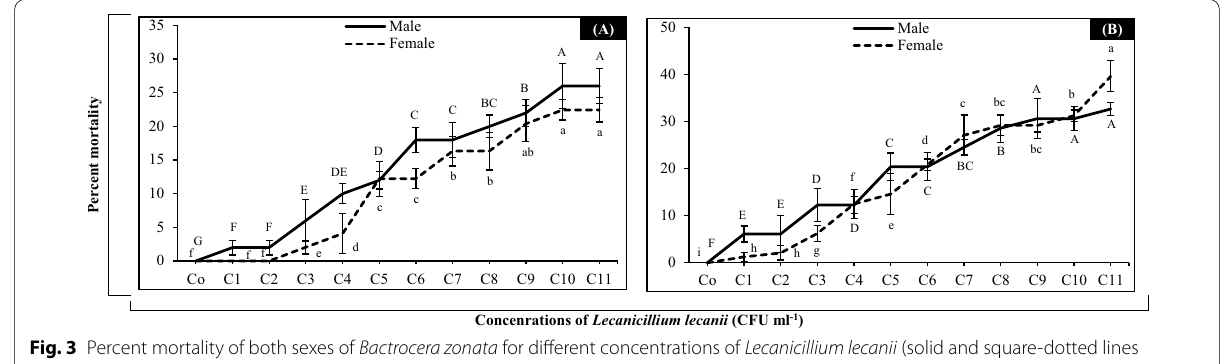
Fig. 3 Percent mortality of both sexes of Bactrocera zonata for different concentrations of Lecanicillium lecanii (solid and square-dotted lines represent mortality of male and female Bactrocera zonata , respectively; Capital and small letters represent mortality of male and female Bactrocera zonata , respectively) at 5 days post-exposure intervals (a) and 7 days post-exposure intervals (b) . Concentrations on x-axis represents C0 Control, = C1 1 10 3 CFU ml − 1 , C2 5 10 3 CFU ml − 1 , C3 1 10 4 CFU ml − 1 , C4 5 10 4 CFU ml − 1 , C5 1 10 5 CFU ml − 1 , C6 5 10 5 CFU ml − 1 , = × = × = × = × = × = × C7